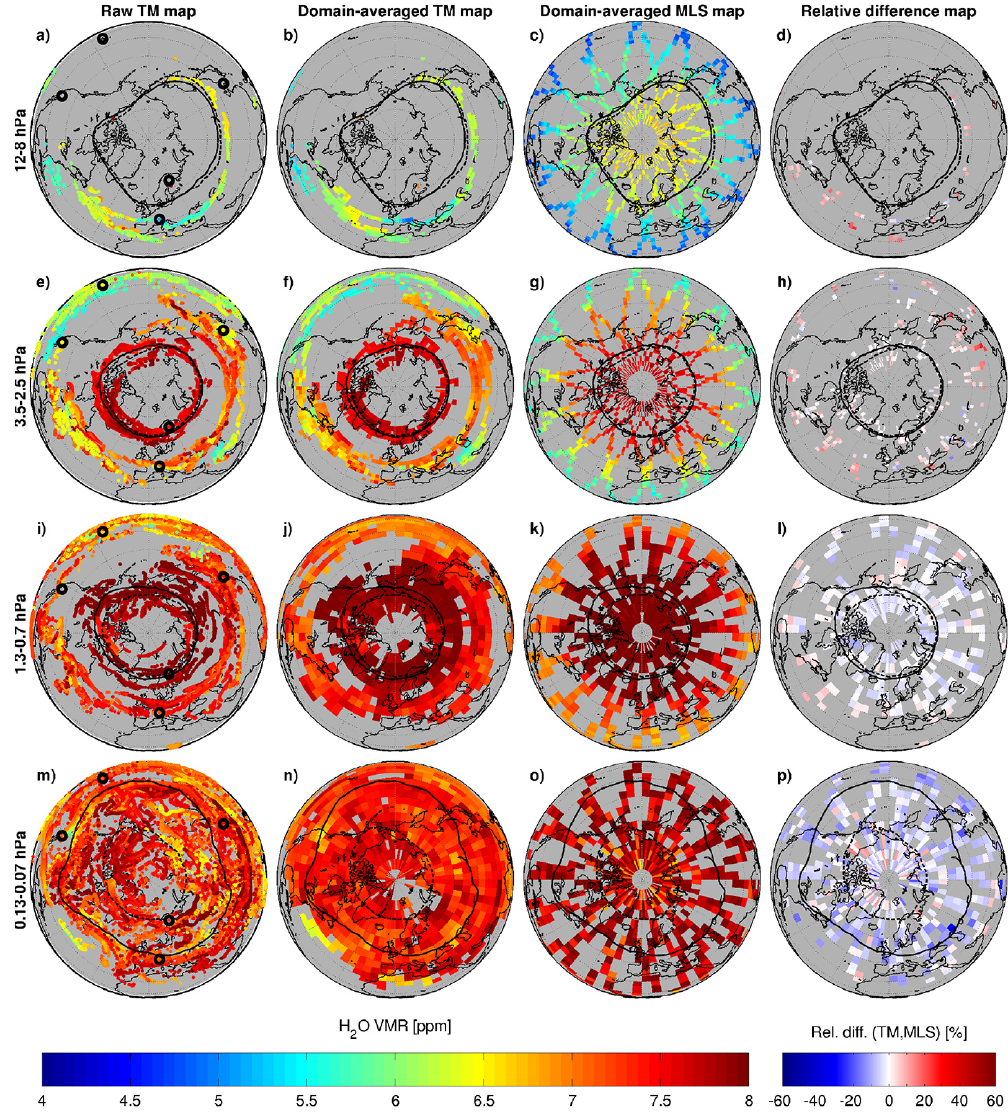
Figure 4. Case B: same as Fig. 3, except for 22 September 2012, 12:00UTC close to the fall equinox.